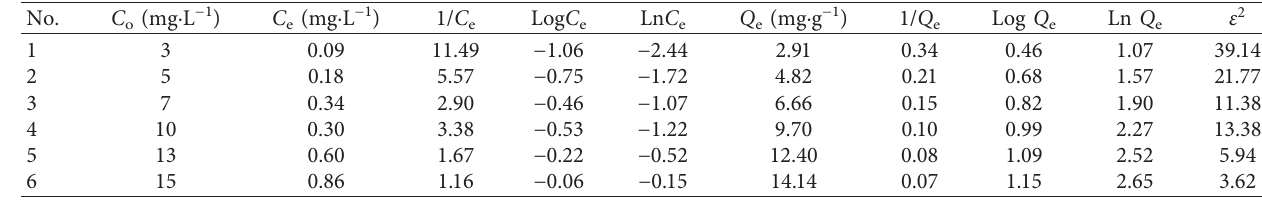
C andC o e : initial MB concentration and absorbed MB concentration, respectively. Table 15: Langmuir, Freundlich, Temkin, and Dubinin–Radushkevich isotherm constants of MB adsorption using YPS. Langmuir constant